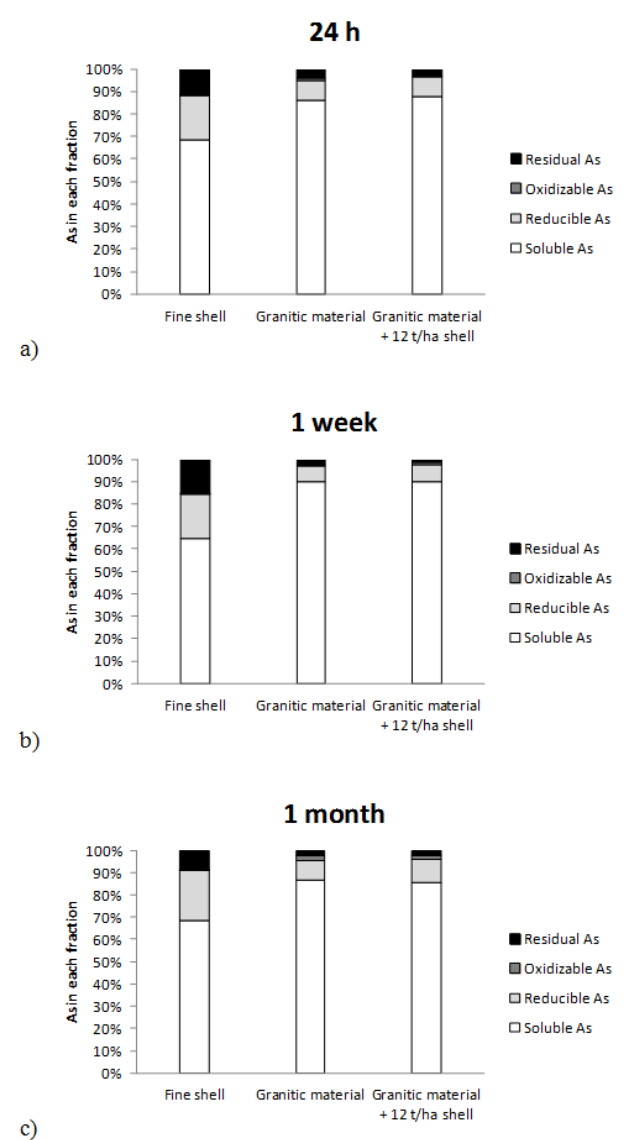
Figure 5. Percentages of the various fractions of As(V) adsorbed af- ter 24h (a) , 1 week (b) and 1 month (c) of incubation. Average val- ues for three replicates, with coefficients of variation always <